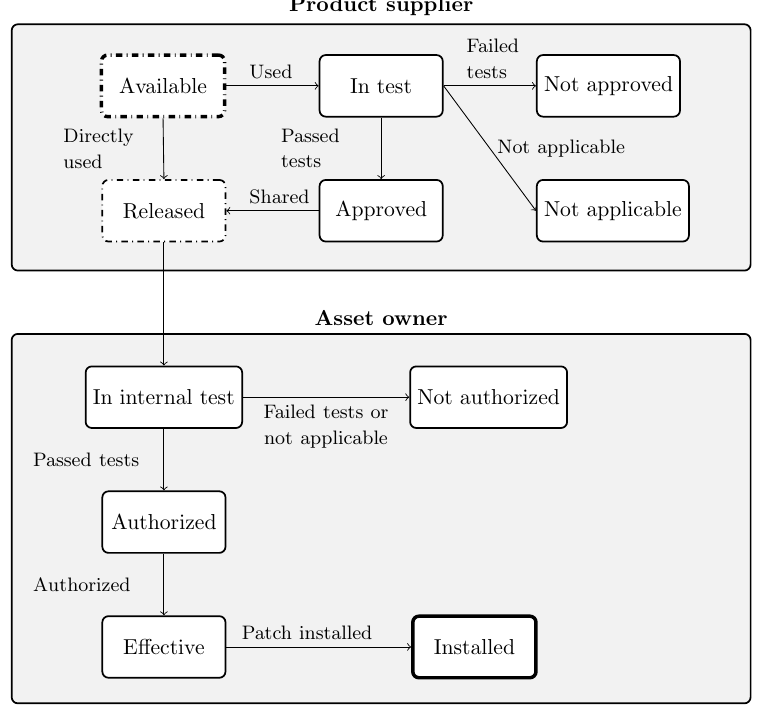
Figure 9. Patch lifecycle model [11,16]. Table 5. Patch lifecycle states defined by IEC 62443-2-3